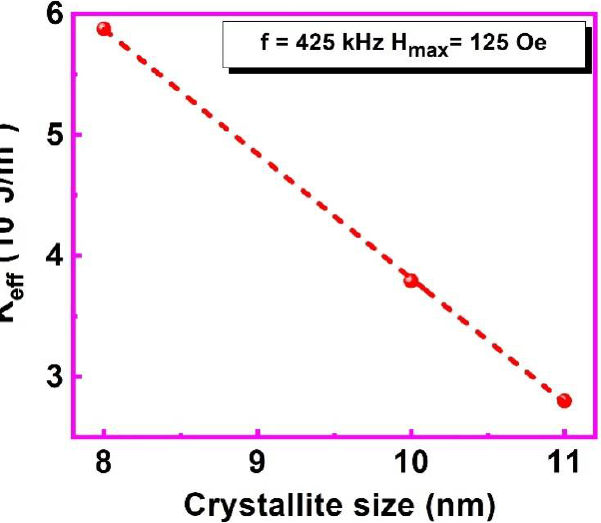
Figure 14. Dependence of effective anisotropy constant on average crystallite size of Co 15 Ni 85 NPs milled at 1425 rpm for 200, 300, and 500 min.